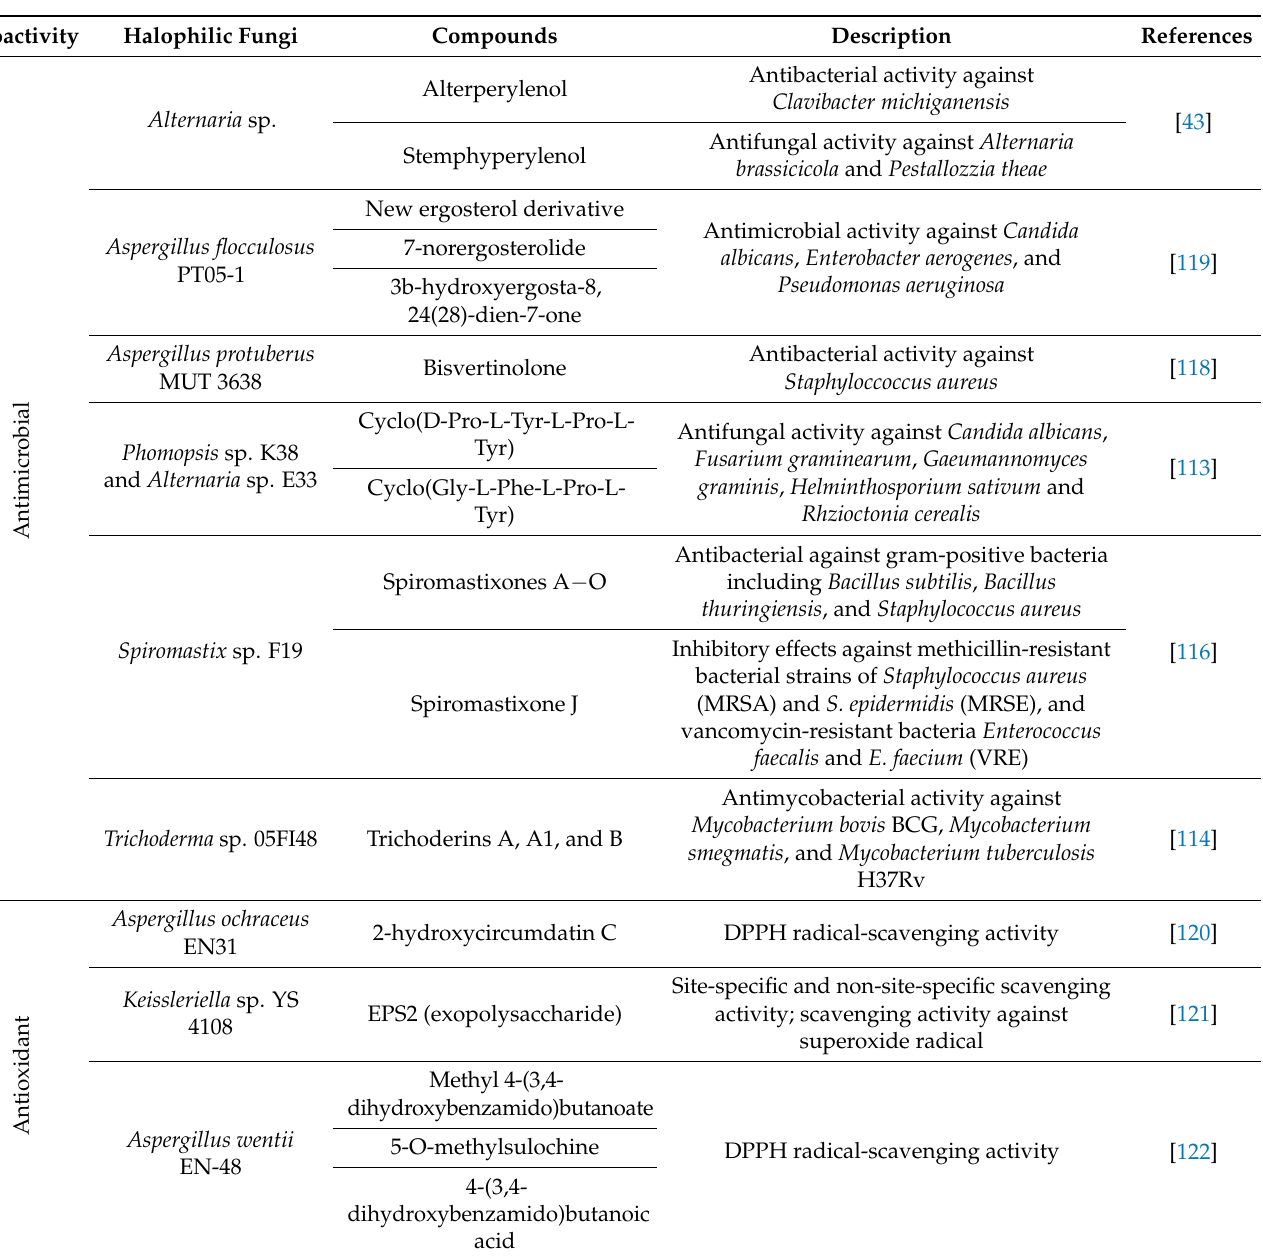
Table 5. Different categories of bioactive compounds extracted from halophilic